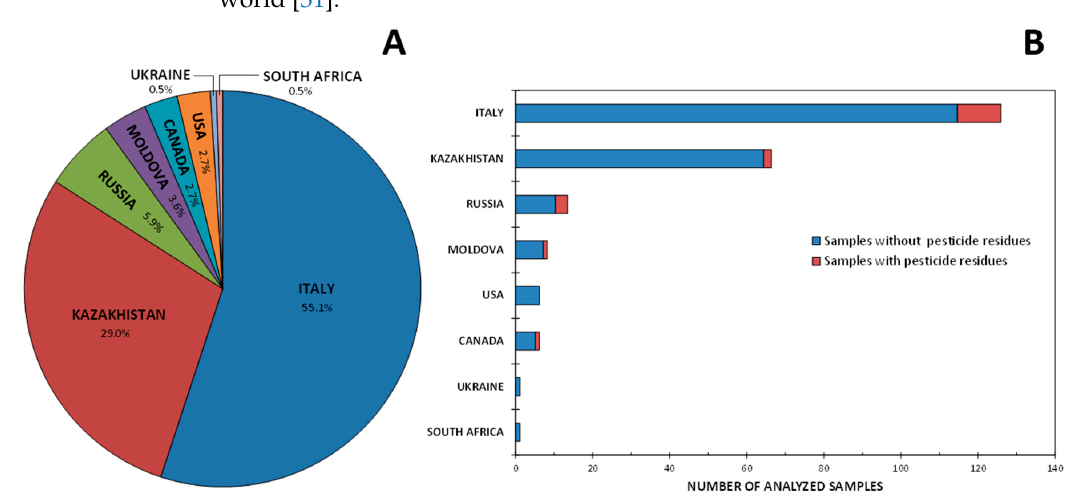
Figure 2. ( A ) Origin of cereal and legume samples collected during the years 2018 and 2019 and ( B ) number of contami- nated samples.